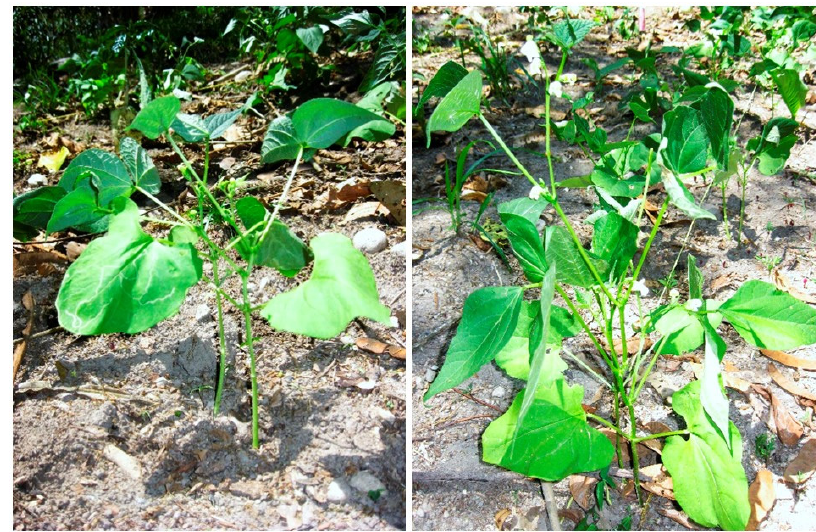
Figure 4. Red kidney beans planted in an intercrop, non-inoculated control ( left ) and inoculated with the RZC12 strain ( right ). Table 6. Effect of inoculation with Rhizobium-RZC12 on the growth and root nodulation of red kidney beans in field studies.